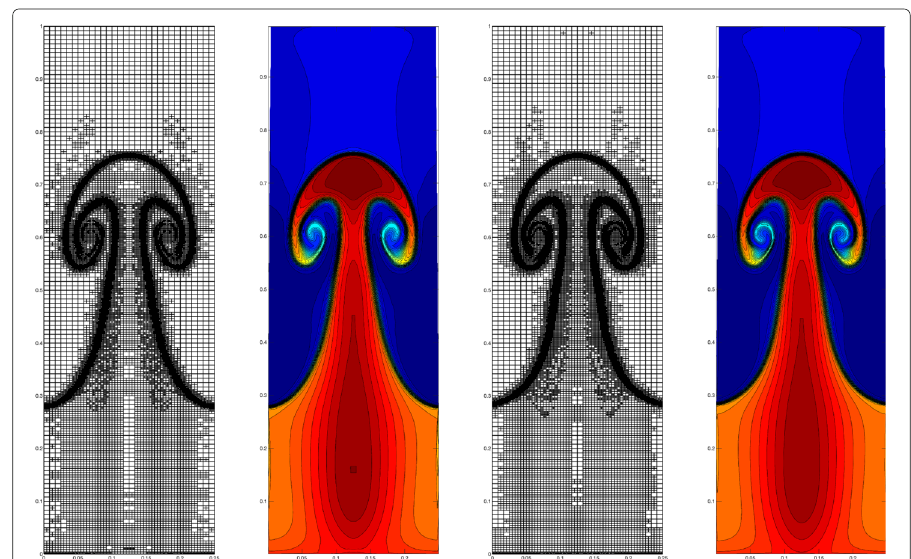
Fig. 14 NS simulations for Rayleigh-Taylor instability with Reynolds number Re ∞ = 50000. From left to right: adaptive mesh for P 1 element; 30 equally spaced density contours from 0.8728 to 2.2249 for P 1 element; adaptive mesh for P 2 element; 30 equally spaced density contours from 0.8733 to 2.2262 for P 2 element